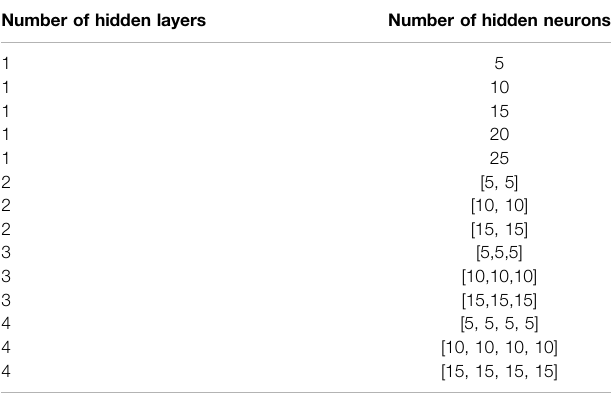
TABLE 4 | Some combinations of different numbers of hidden layers and hidden neurons tested in this research. Number of hidden layers